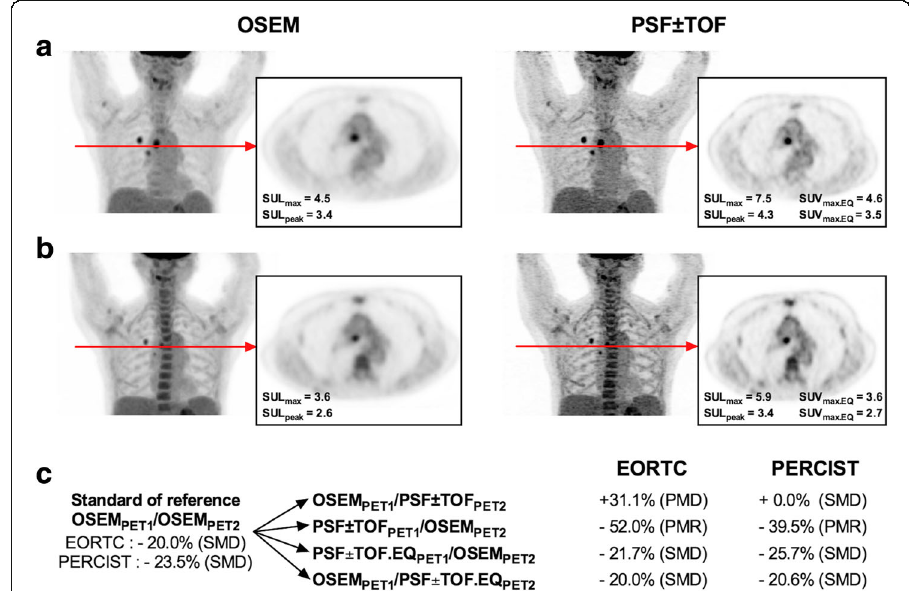
Fig. 5 Representative images of a 66-year-old female with a NSCLC staged T1N2M0 or stage III according to AJCC stadification treated by chemotherapy. This patient was classified as SMD with EORTC classification and PERCIST according to the OSEM PET1 /OSEM PET2 standard of reference, while OSEM PET1 /PSF ± TOF PET2 , a scenario mimicking a system upgrade during a trial led to a PMD with EORTC classification. The use of the EQ.PET methodology correctly classified the patient as SMD. a MIP images and transverse slices at the level of a mediastinal nodal involvement on OSEM and PSF ± TOF reconstructions for baseline scan. b MIP images and transverse slices at the level of a mediastinal nodal involvement on OSEM and PSF ± TOF reconstructions for post-treatment scans. c % change in SUL max and SUL peak for EORTC classification and PERCIST according to the different